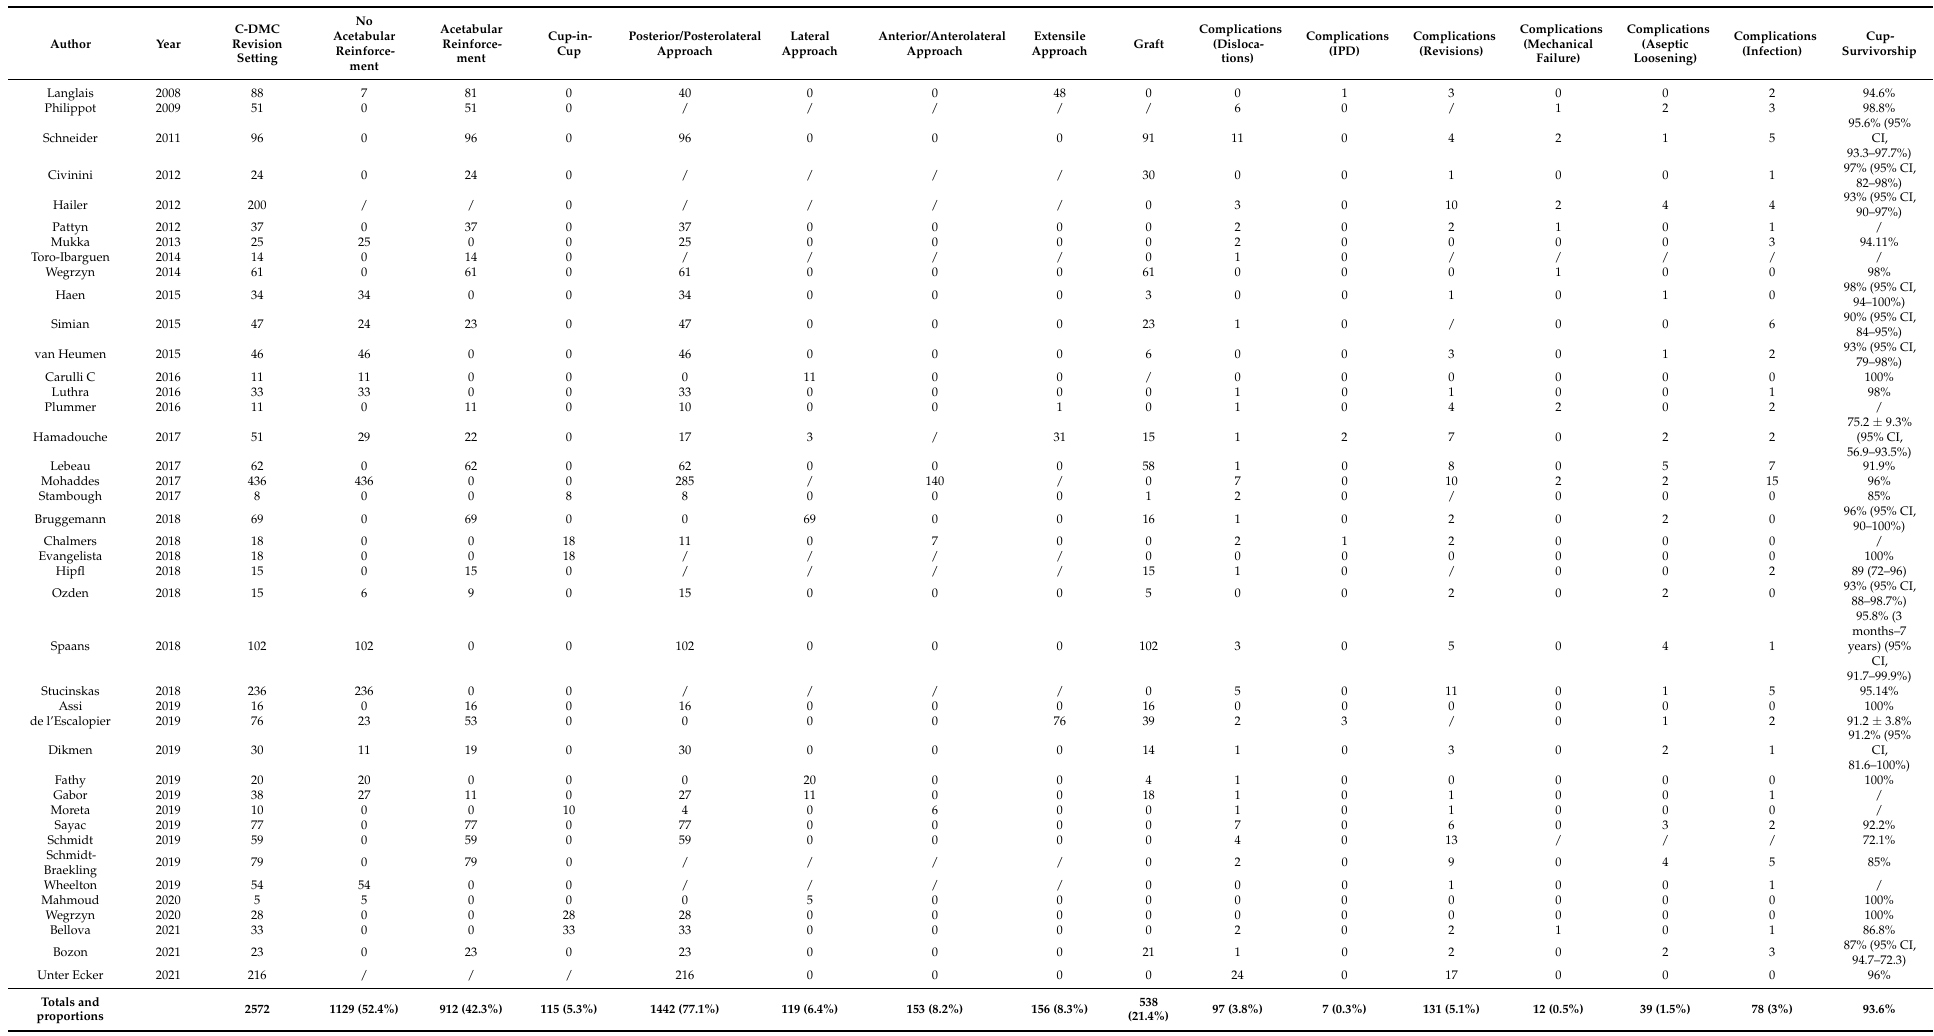
Table 7. Cemented dual mobility cup in the revision